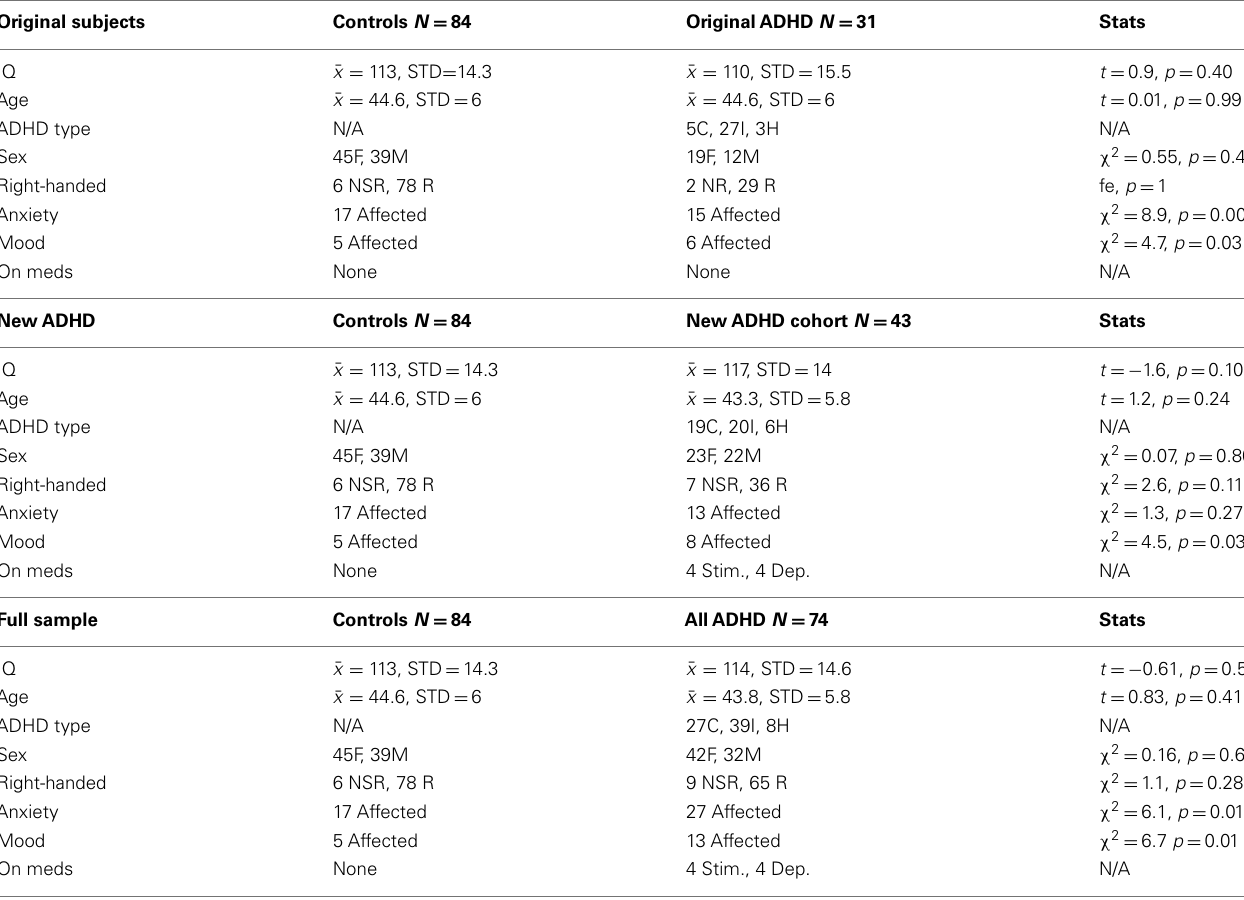
Table 3 | Demographic information for subjects comprising three analyses of our effect of interest (P8–P7 beta2 asymmetry)